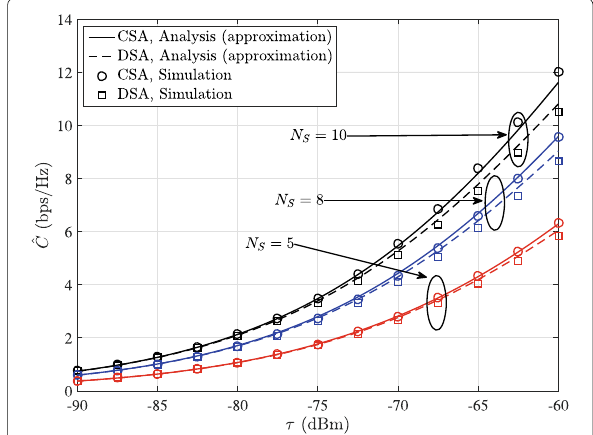
between the capacities with the CSA and the DSA gets bigger as N S grows.